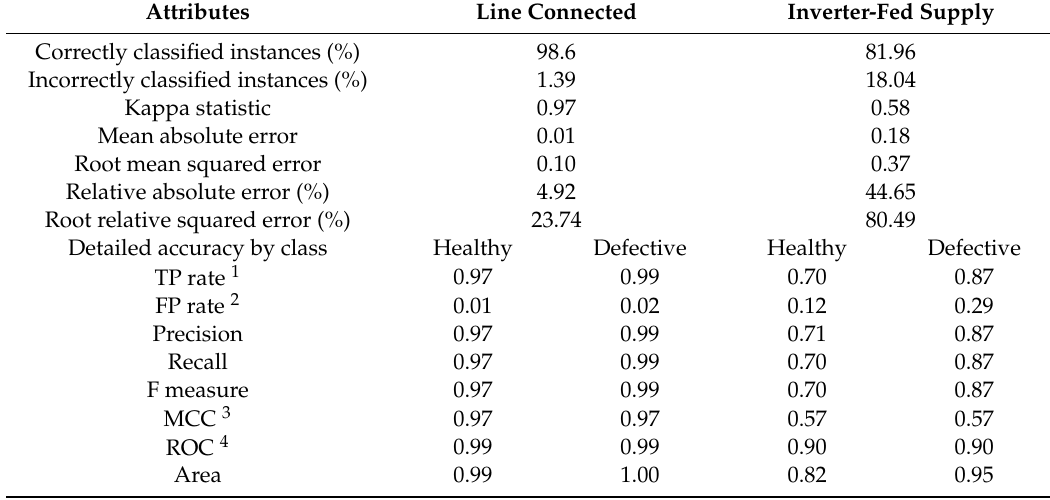
Table 3. Fault classification—motor operation under healthy / defective conditions.